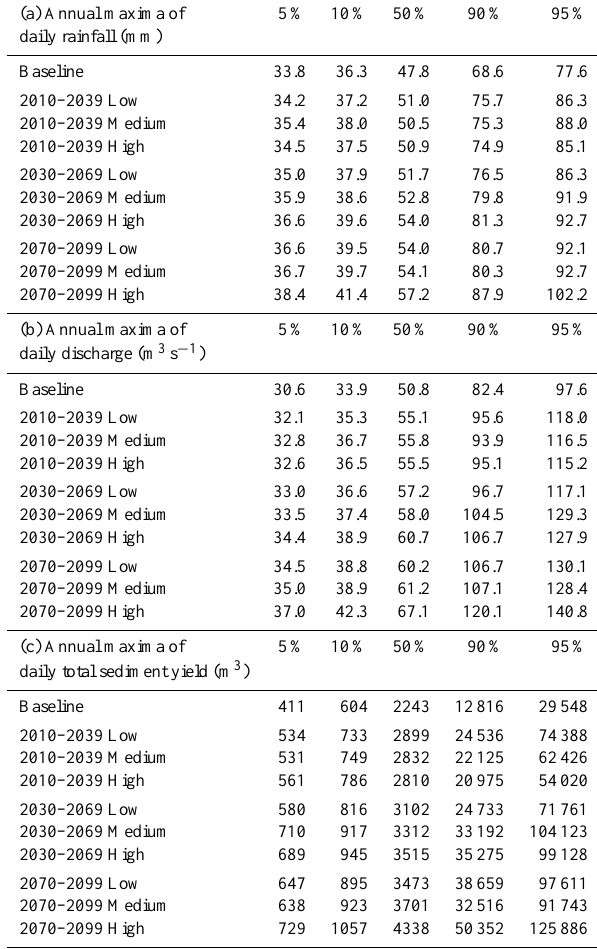
Table 2. Percentiles of the annual maximum distribution for the baseline and 9 future scenarios for (a) daily rainfall (mm), (b) dis- charge (m 3 s − 1 ) and (c) total sediment yield (m 3